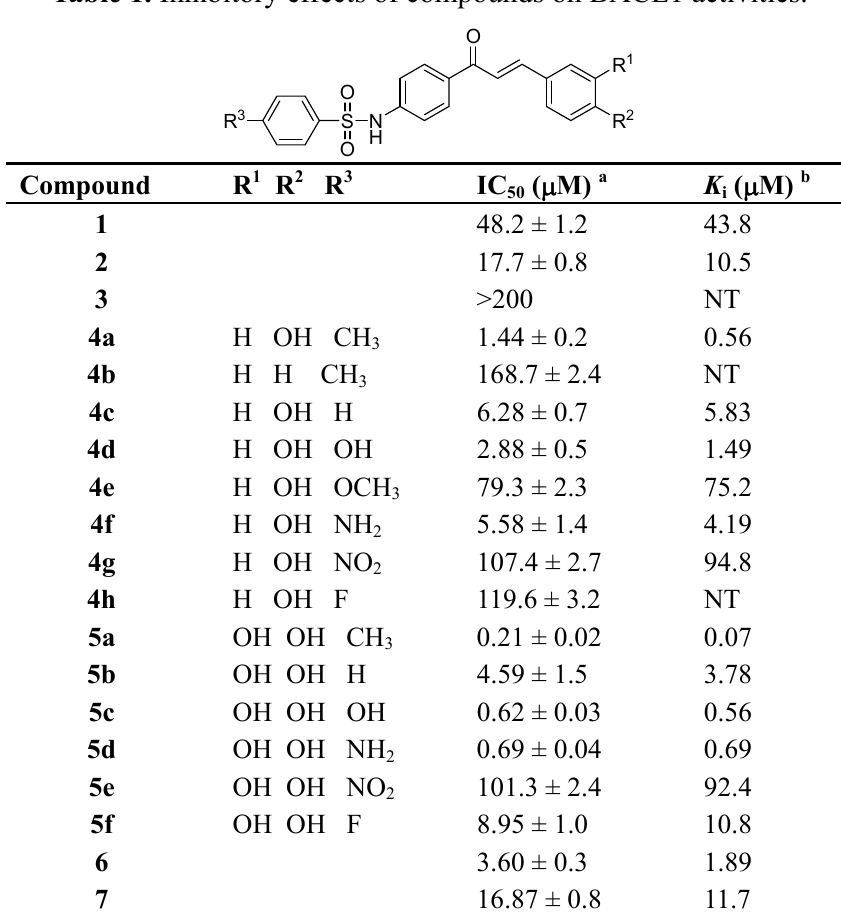
Table 1. Inhibitory effects of compounds on BACE1